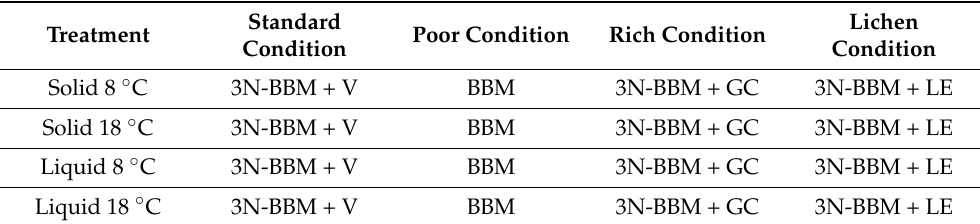
Table 1. Treatments used to test phenotypic plasticity. All the treatments were subjected to 50 µ mol/m − 2 s − 1 PPFD with a light:dark cycle of 16:8 h. for 21 days. Abbreviations: 3N (3-fold nitrogen), BBM (Bold Basal Medium), V (vitamins), GC (glucose and caseine) and LE (lichen extract). See Appendix